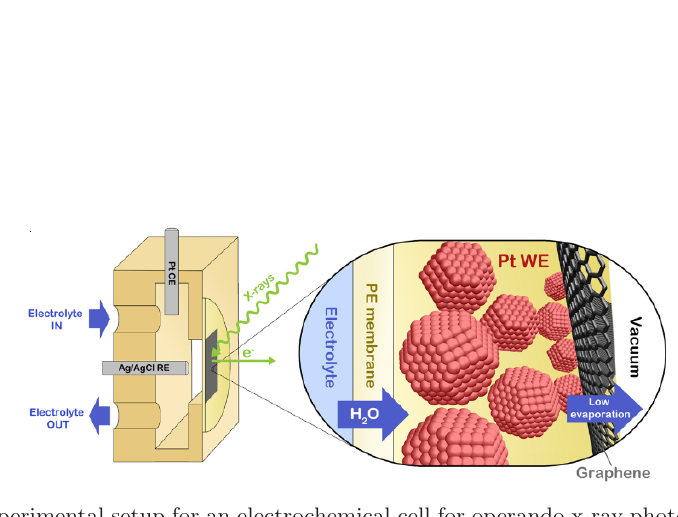
Fig. 20. – Experimental setup for an electrochemical cell for operando x-ray photoelectron spec- troscopy. The group of Schl¨og et al. have recently published several spectacular exeriments that allow to monitor the change development of the bulk and the surface during an electro- catalytic reaction by combining electrocatalytic experiments and synchrotron radiation. Figure from [83] under the terms of this ACS AuthorChoice/Editors Choice via Creative Commons CC-BY